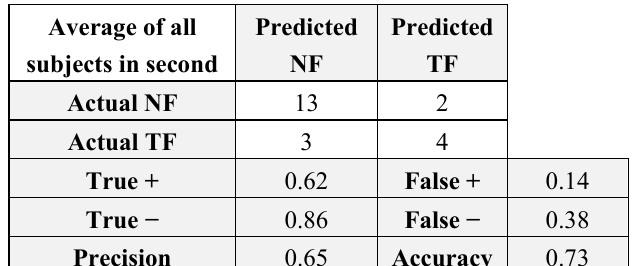
Table 6. Confusion matrix of 1D spectro_std for classification of Transition-to-Fatigue and Fatigue (NF = Non-Fatigue and TF = Transition-to-Fatigue) averaged across the full set of